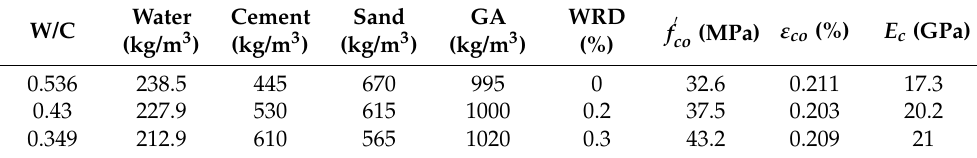
Table 1. The mixes and mechanical properties of